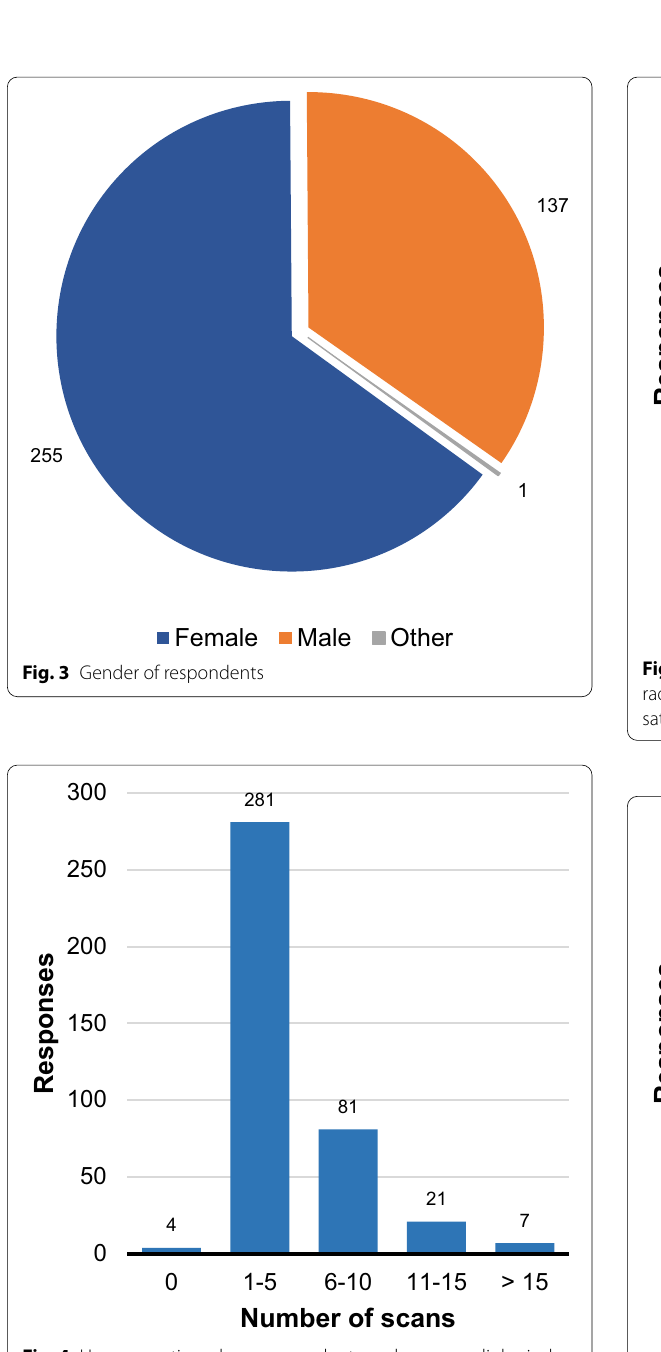
Fig. 4 How many times have respondents undergone radiological scans in the last 2 years?